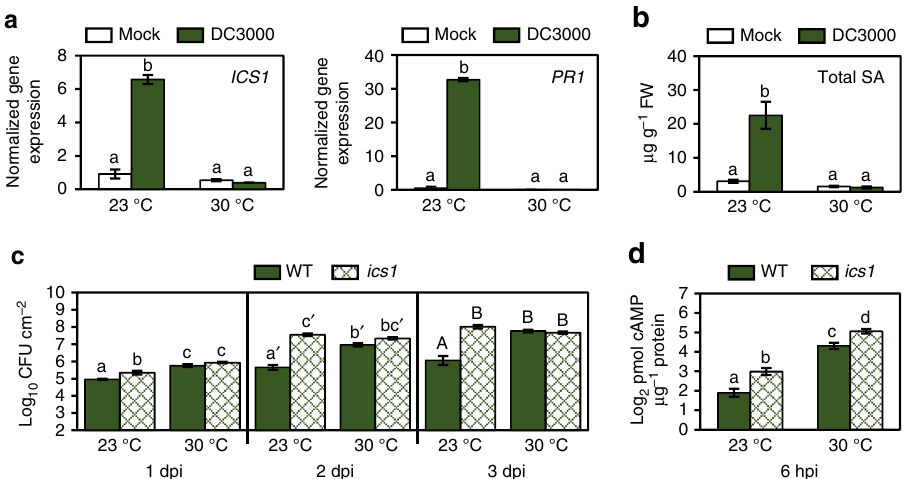
Fig. 2 Enhanced disease at elevated temperature corresponds to loss of SA biosynthesis. a SA marker gene expression ( n = 3) and ( b ) SA metabolite quanti fi cation ( n = 4) 24 h after vacuum-in fi ltration with mock or Pst DC3000. qPCR was used for gene expression analysis, with expression of ICS1 and PR1 normalized to the expression of PP2AA3 . SA and SAG metabolites were quanti fi ed using LCMS, converted to ng, normalized by sample fresh weight (FW) mass (g), and then combined and reported as total SA. c Bacterial growth in WT and ics1 mutant plants ( n = 4) at 1, 2 and 3 days after syringe- in fi ltration (dpi) with Pst DC3000. d Translocation of bacterial effectors in WT and ics1 mutant plants ( n = 4) syringe-in fi ltrated with Pst DC3000(P nptII :: avrPto-CyaA ). All data are representative of three independent experiments, and are presented as the mean ± s.e.m., with n = biological replicates. Letters indicate statistical signi fi cance based on a two-factor ANOVA with Tukey ’ s HSD post hoc analysis ( p < 0.05); samples sharing letters are not signi fi cantly different. Data for each time point in ( c ) were analysed